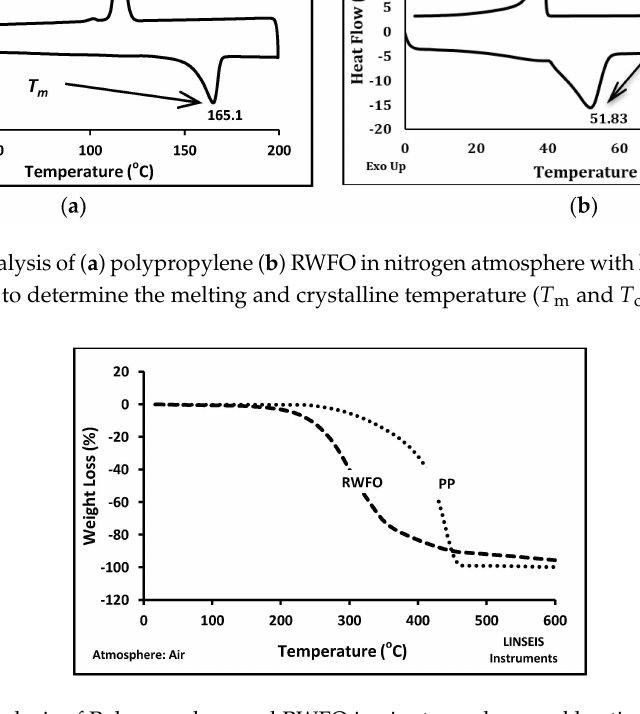
Figure 4. TGA analysis of Polypropylene and RWFO in air atmosphere and heating rate of 10 ˝ C/min to determine degradation temperature of binder